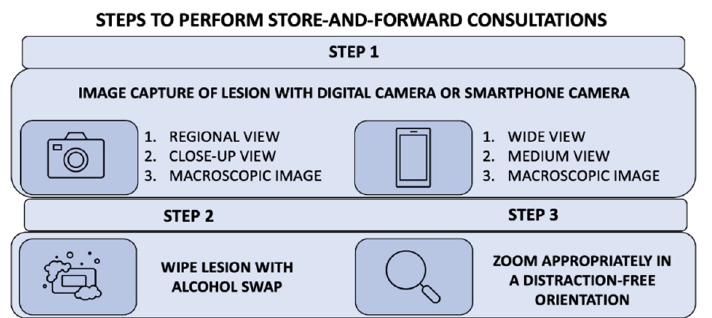
Figure 5. Teledermoscopy using an asynchronous delivery system. The summary of three key steps describes how to perform teledermoscopy via an asynchronous store-and-forward telemedicine consultation successfully. Asynchronous teledermatology is widely utilized in operational dermatology.